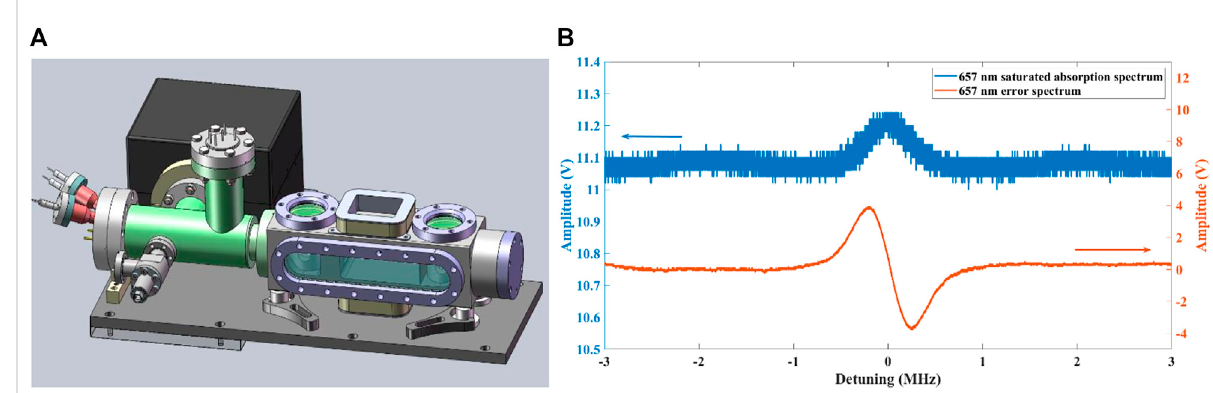
FIGURE 3 Design of the atomic beam vacuum tube and the clock transition spectrum. (A) Design of the atomic beam vacuum tube. Two fl uorescence detection windows are set to test the beam collimation. The 657 nm clock laser incident at the middle of the side window. (B) The clock transition spectrum. The blue curve is the saturated absorption spectrum. The linewidth of the spectrum is about 450 kHz. The red curve is the error